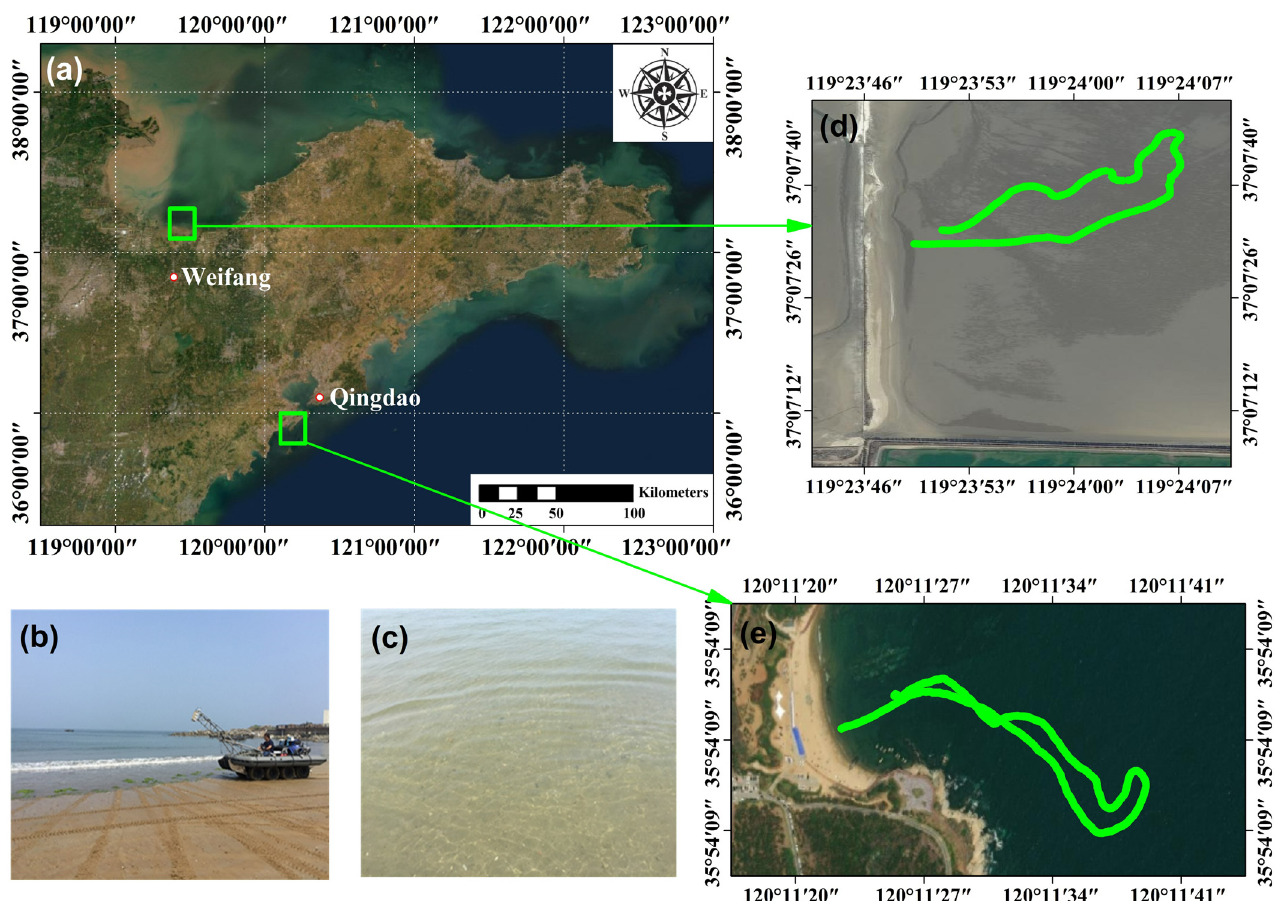
Figure 8. ( a ) Study area locations (green boxes). ( b ) Image of the equipment platform. ( c ) Representative image of the water environment in the study areas. ( d , e ) Measurement trajectories represented by green lines at Qingdao ( d ) and Weifang ( e ).